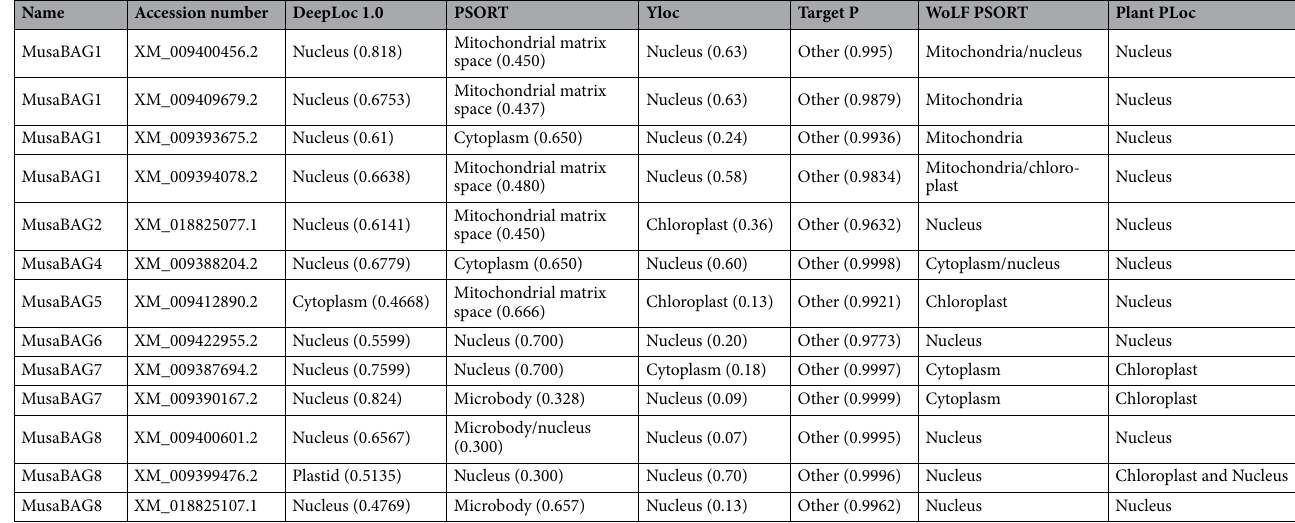
Table 2. Prediction of the subcellular localization MusaBAG proteins (confidence scores mentioned in